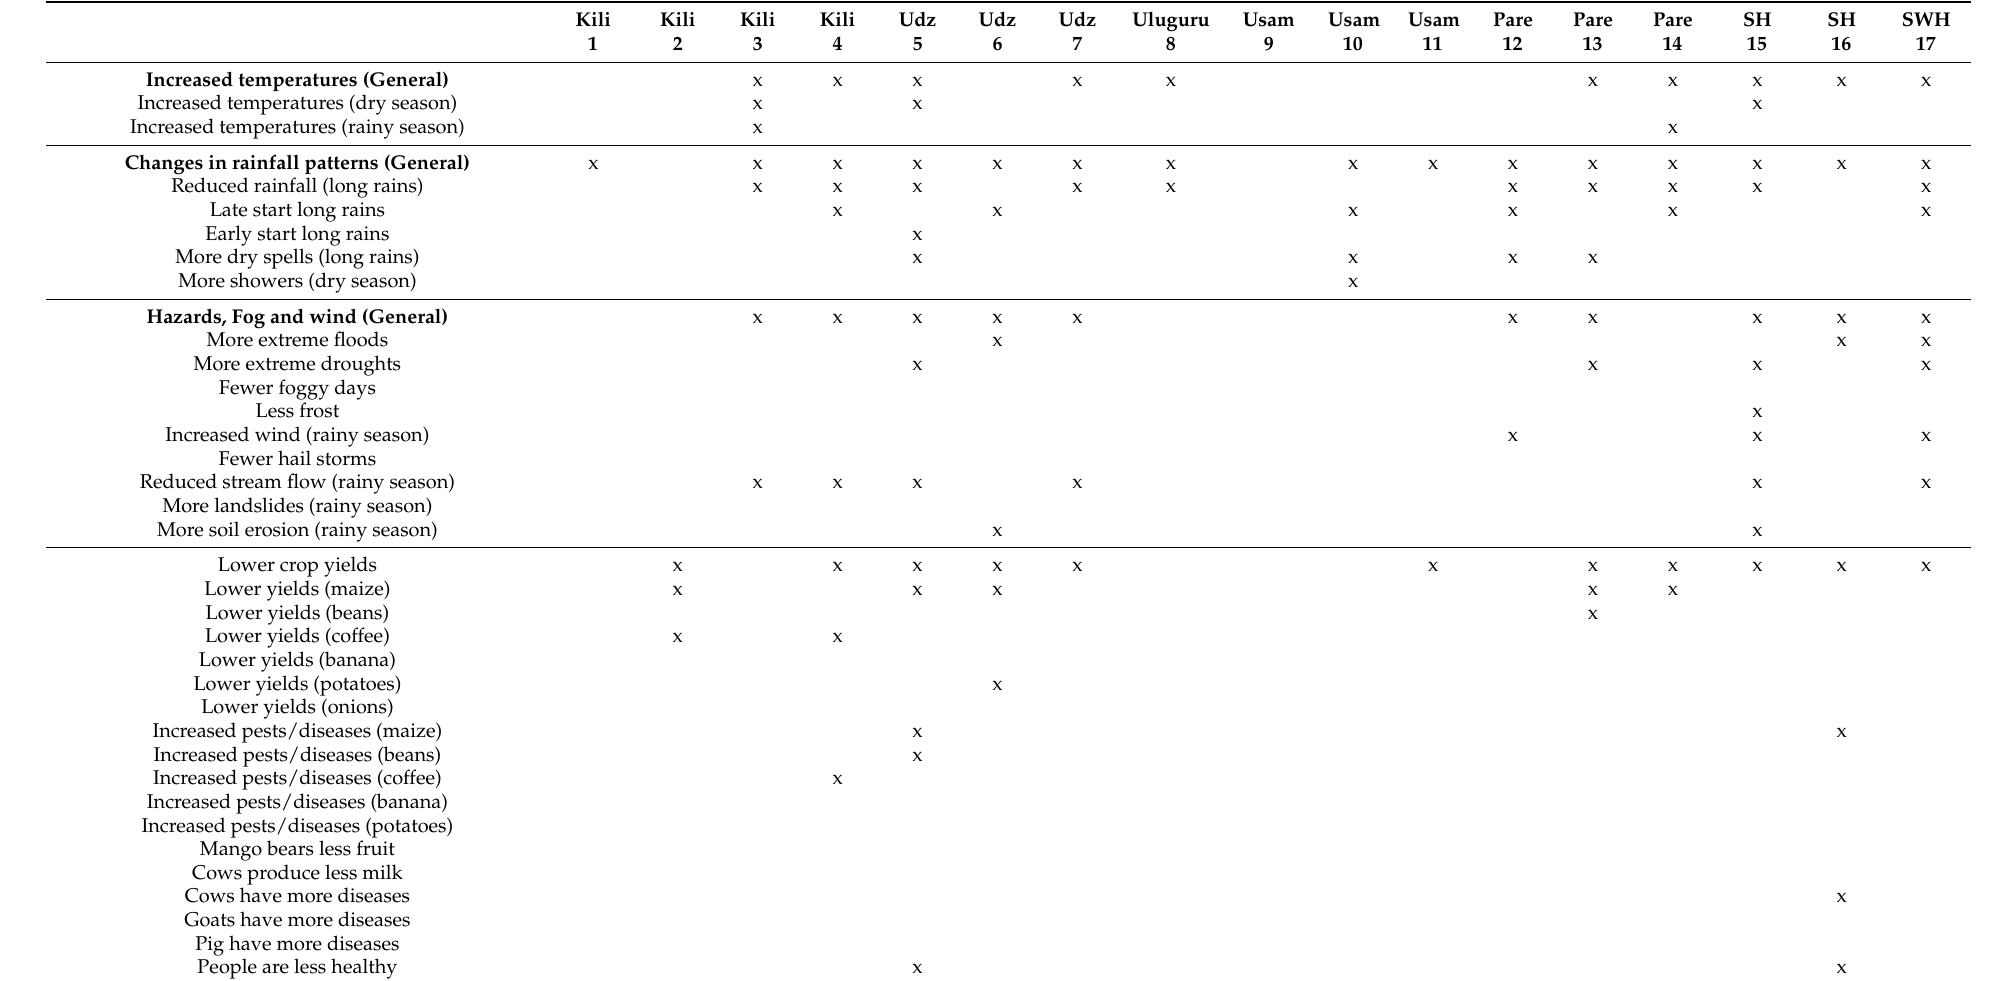
Table 3. Climatic changes and impacts as reported by other studies on farmers’ perceptions in Tanzania’s mountains. (H: Highlands). 1 [63]; 2 [48]; 3 [27]; 4 [59]; 5 [45]; 6 [60]; 7 [61]; 8 [62];